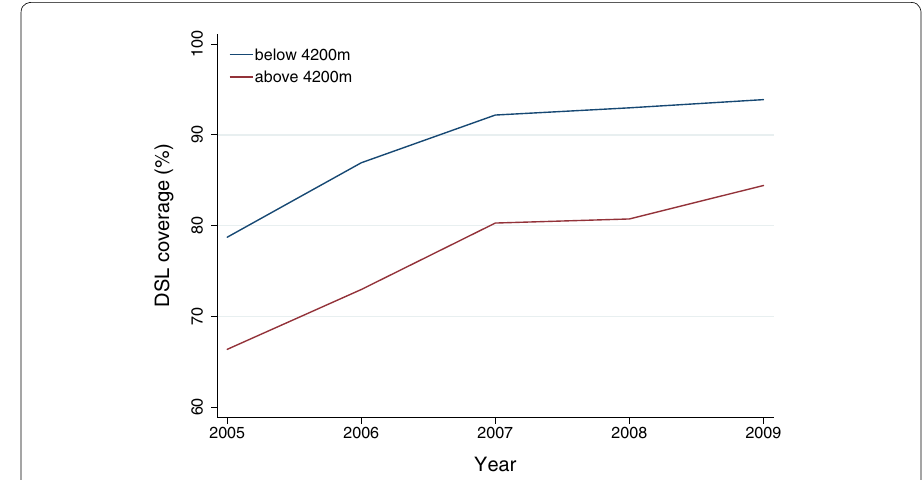
Fig. 2 DSL Coverage in Above-Threshold and Below-Threshold Municipalities. The figure shows the share of households with access to DSL in the period 2005–2009. The blue ( red ) line indicates municipalities that are less (more) than 4200 m away from their assigned main distribution frame (MDF). Source: Falck et al. (2016)